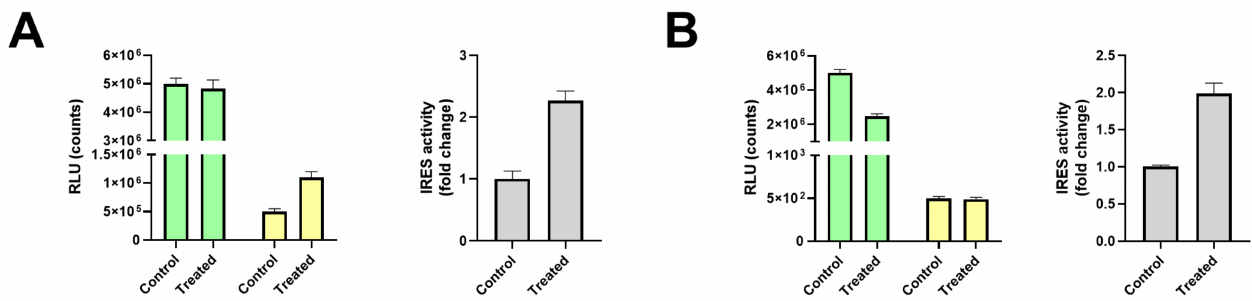
Figure 5. Potential misinterpretation of activity ratios without individual cistron data. Reporting of ratios alone can be misleading due to different underlying reasons for regulation. For example: ( A ) IRES ratio induction, caused by an increase of second cistron activity. ( B ) IRES ratio induction, due to a decrease of first cistron activity. Note that IRES activity in this hypothetical example is very low and might be close to the detection limit or background levels. Naturally, both first and second cistrons can also be induced or reduced, wherein slight differences can lead to IRES induction or repression. Additional normalization strategies can be used to correct for changes in cap translation (monocistronic β Gal co-transfection), cell number, or protein content. Graphs were generated for illustration purposes using hypothetical data, on the basis of our own experience with the bicistronic reporter